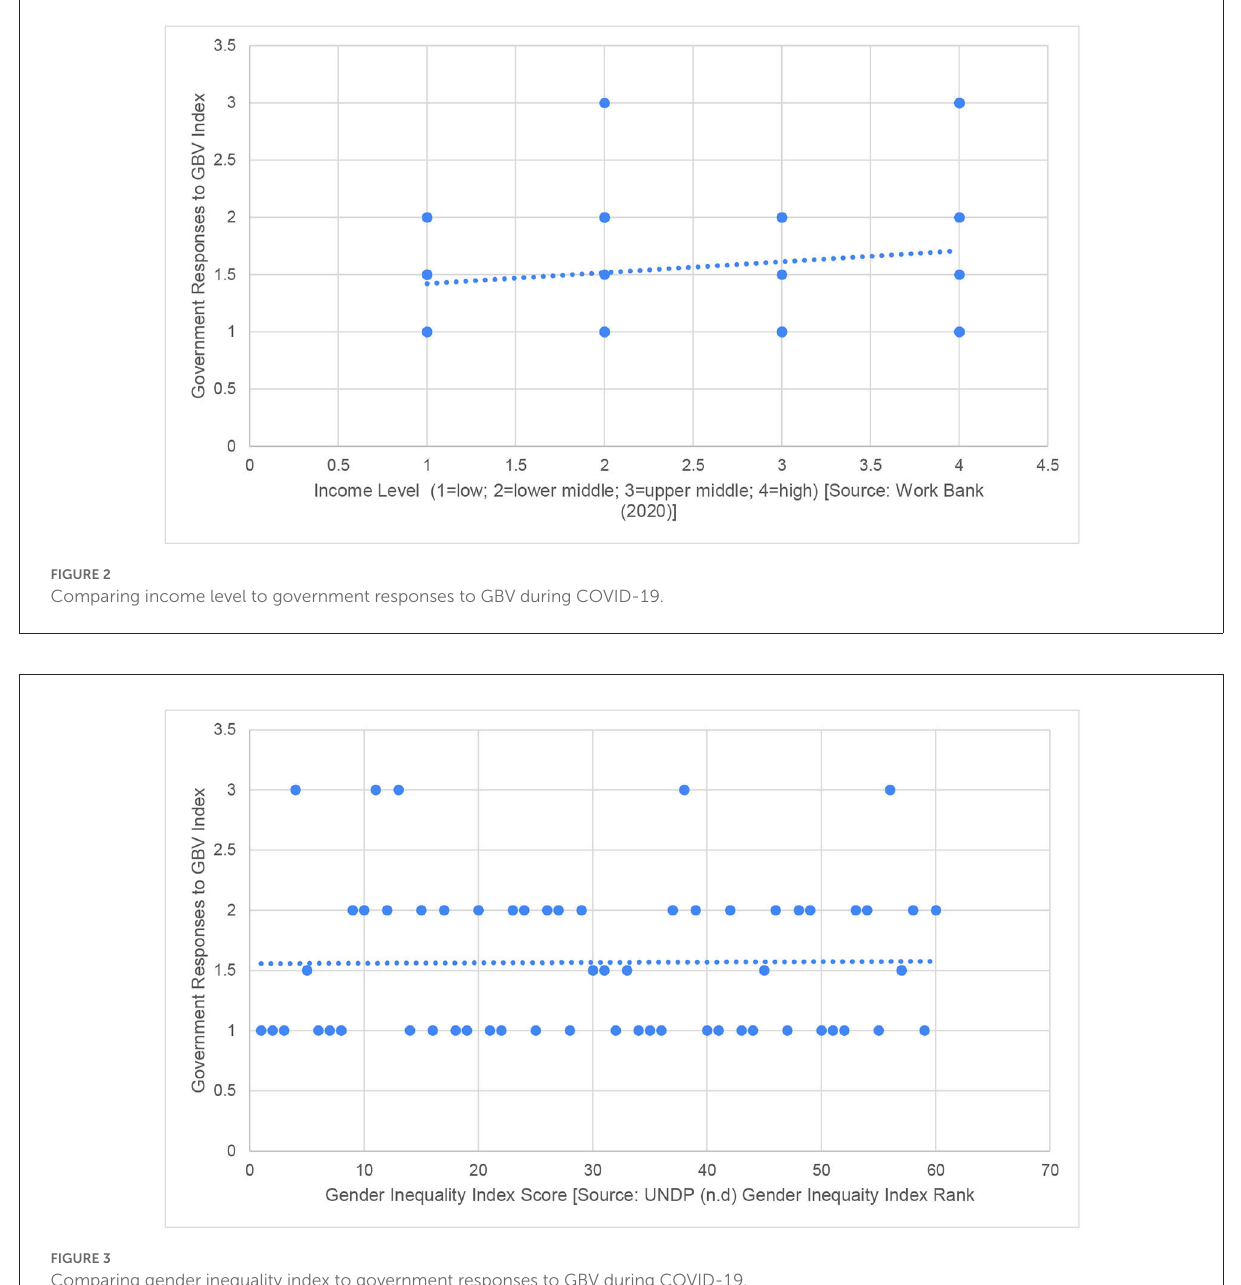
of the representation of women in a country’s government, and hence, measures the likelihood that women leaders can shape policy. Again, the relationship was not statistically significant (Spearman’s rho = − 0.07, p = 0.583). As can be seen in Figure 4, as countries with low levels of political parity have had similar responses to the pandemic as those with high